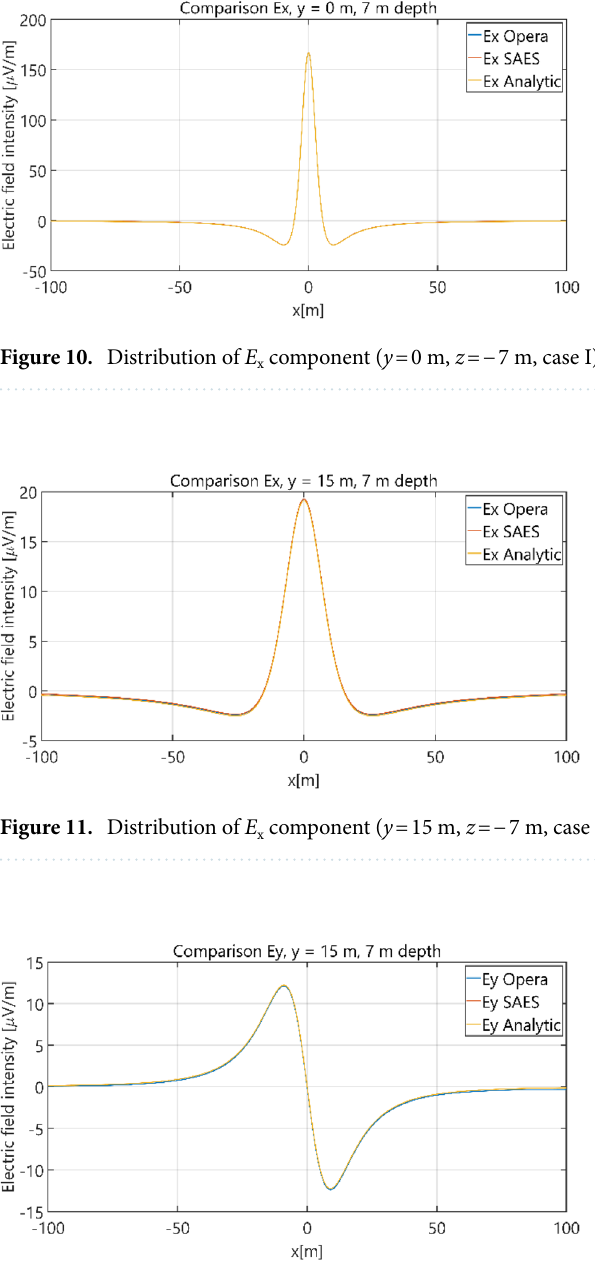
Figure 12. Distribution of E y component ( y = 15 m, z = − 7 m, case